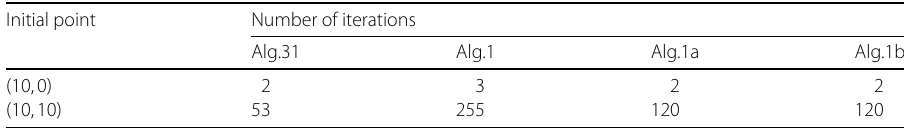
Table 3 Iterations from Alg.31, Alg.1, Alg.1a and Alg.1b respectively